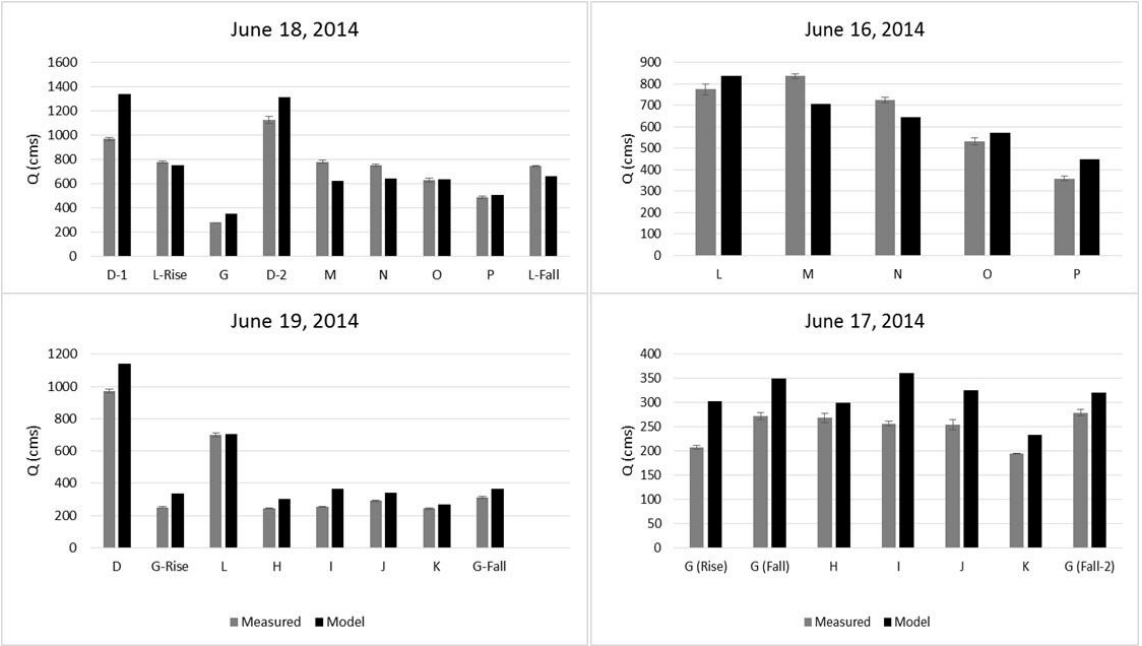
Figure A3. Comparison of modeled and measured discharge at select distributary channel loca- tions—see Figure A1 for locations.